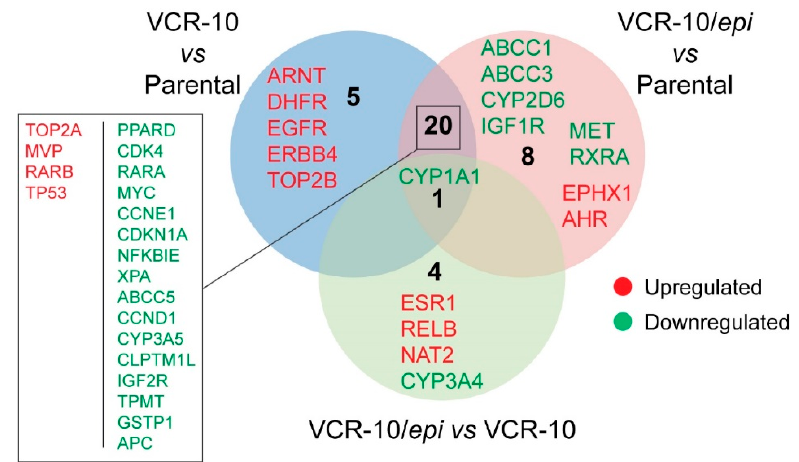
Figure 5. Identification of genes involved in drug resistance in epi -enprioline-treated and non-treated VCR-10 cells. The Human Cancer Drug Resistance RT² Profiler PCR Array revealed up- and downregulated genes involved in drug resistance in epi -enprioline-treated and non-treated VCR-10 cells. The levels of relative expression of each gene in the two samples are plotted against each other in a Venn-diagram after normalisation was done using the housekeeping genes. The line in the middle indicates relative fold changes. The left and right lines indicate the fold change in gene expression threshold, which was defined as 1.5-fold.